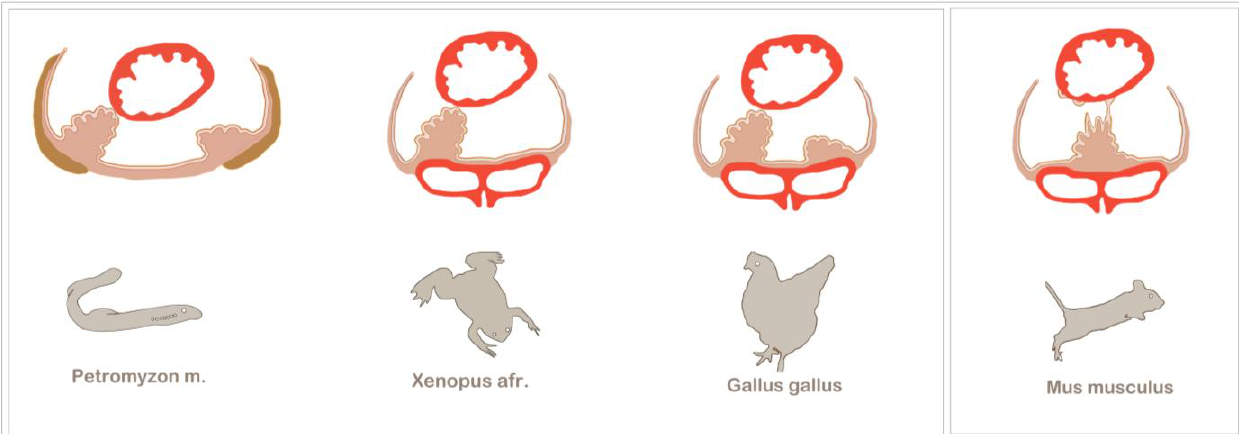
Figure 3. Examples of asymmetric and symmetric PE development among vertebrates. The PE generally forms at the venous pole of the heart and is in close relation to the major veins. Asymmetric PE formation is a conserved feature of vertebrate development. Among the most prominent model organisms are the chick and Xenopus , which both exhibit a right-sided PE cluster that establishes a tissue bridge to the heart. The most basic vertebrate studied so far is the lamprey, Petromyzon marinus, which also displays a right-sided tissue bridge to the heart. Additionally, in the lamprey, the PE is in close spatial relation to the pronephros (olive), and after epicardium formation, the PE cluster gives rise to the highly vascularized pronephric glomeruli. In mouse embryos, asymmetric PE formation has not been observed; instead, the bilaterally formed PE clusters fuse at the midline of the sinus venosus , and PE cell transfer is either accomplished by the release of PE cysts into the pericardial cavity or by being plucked off by the contracting ventricle (modified from